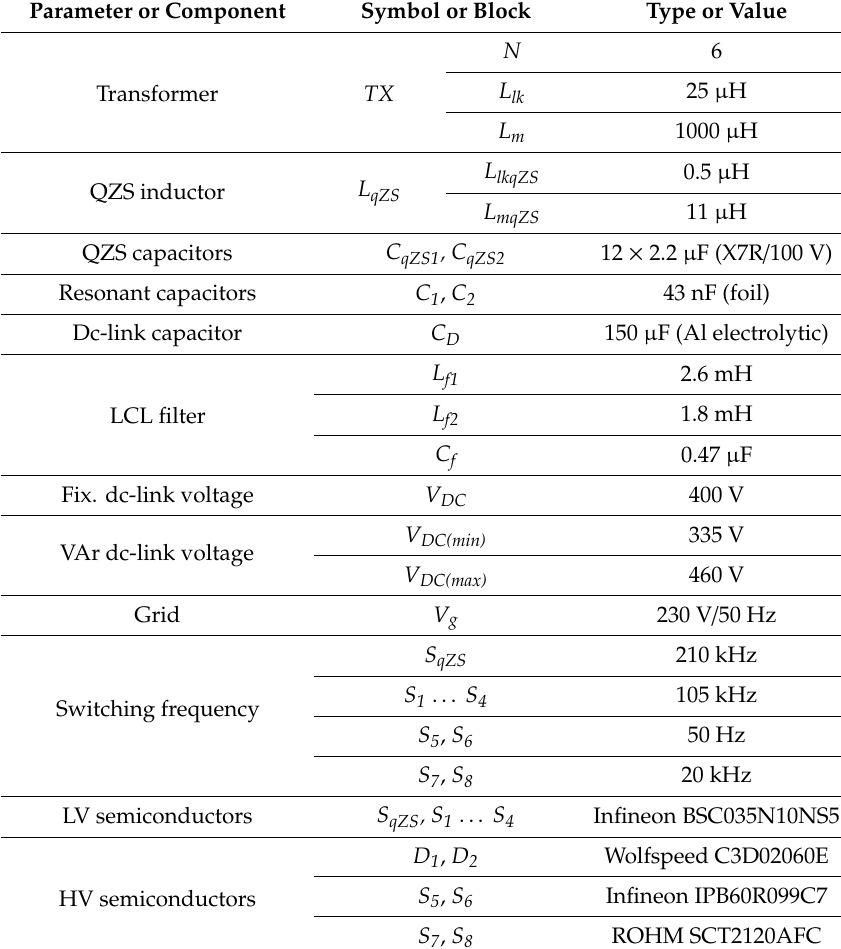
Table 1. Prototype parameters and